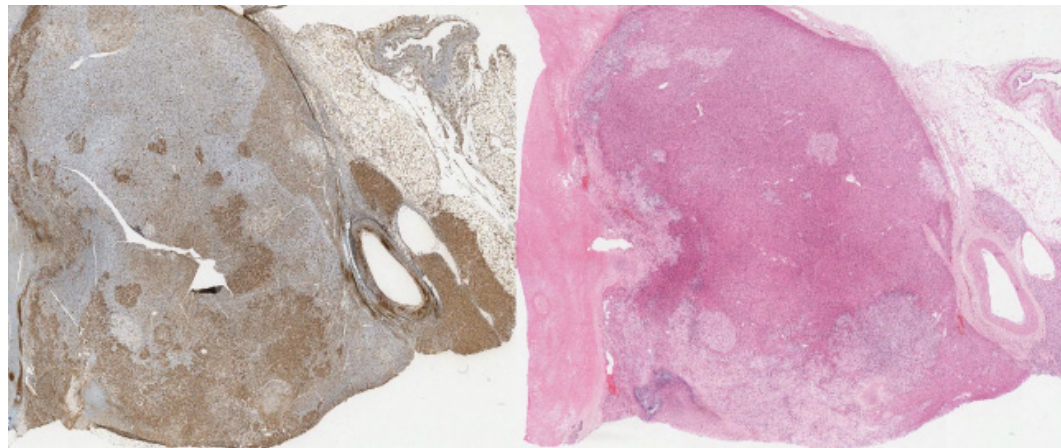
Figure 8. (10x): Vimentin stain: strongly positive sarcomatous component. IHC for comparison.